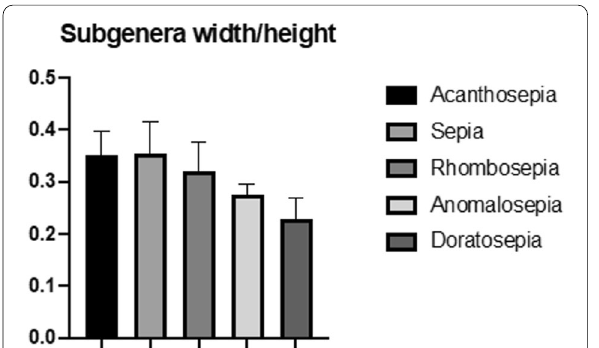
Fig. 9 Bar graph showing width/height of cuttlebone of five different Khromov “subgenera” of sepiids. These categories accepted here as convergent, depth dictated sepion morphologies